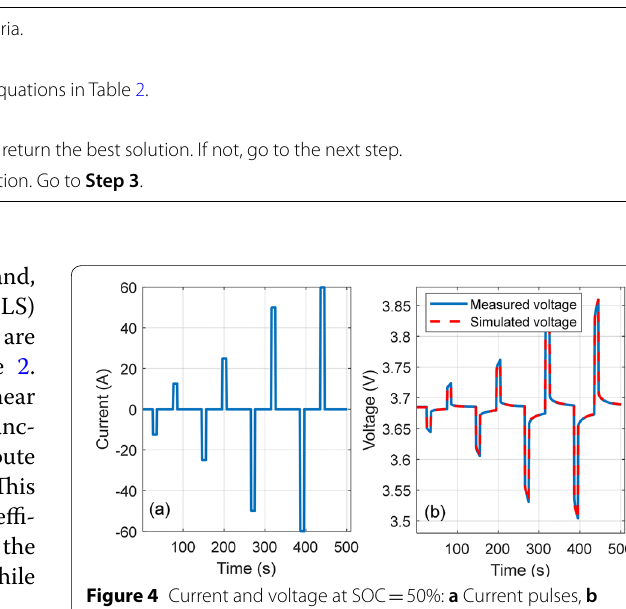
50%: a Current pulses, b =